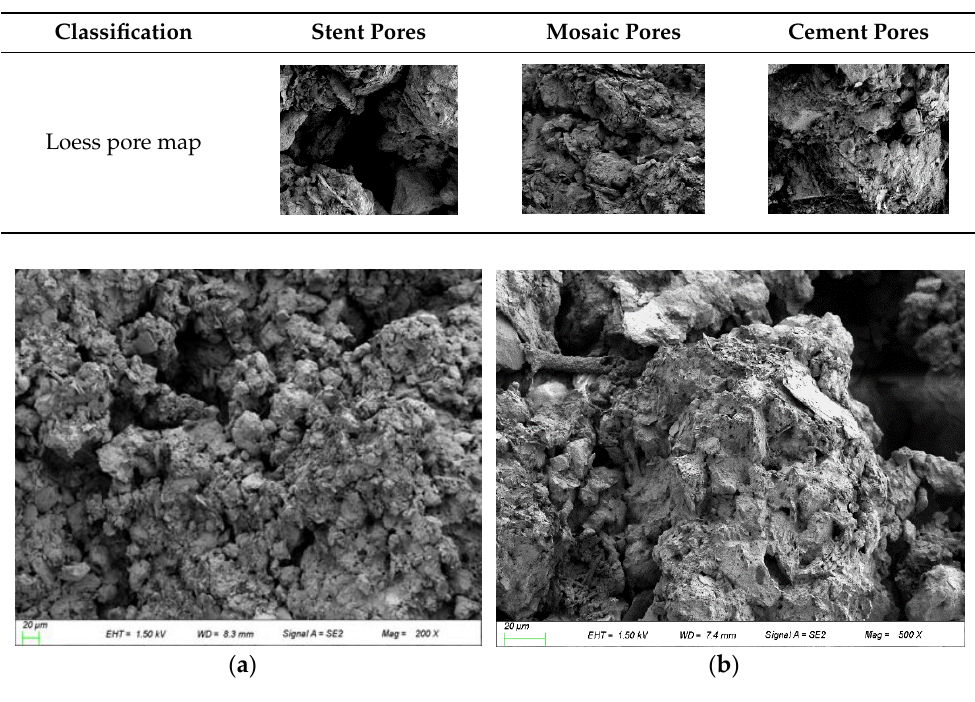
Figure 5. Pore microstructure of loess before MICP curing. ( a ) Loess structure before solidification under 200 times; ( b ) Loess structure before solidification under 500 times.